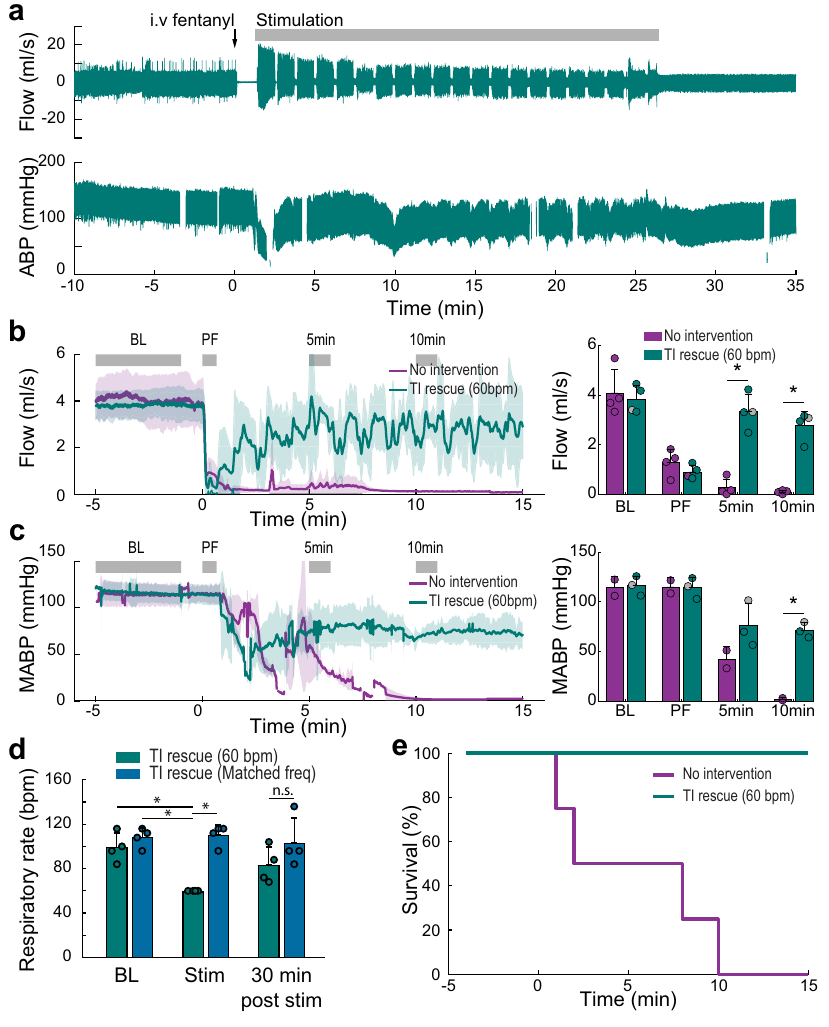
Fig. 2 Intramuscular TI stimulation (TI rescue) prevents fatal apnea by restoring diaphragm activation after opioid overdose. Spontaneously breathing rats under urethane anesthesia received an intravenous injection of fentanyl (30 mcg/kg) suf fi cient to cause lasting respiratory suppression. Following fentanyl dosing, animals received intramuscular TI stimulation or no intervention. Panel a shows an example of sustained restoration of respiratory air fl ow when the stimulation was initiated shortly after opioid overdose-induced apnea, and was delivered with a pattern of 60 s on and 3 s off until spontaneous breathing resumed. Note: The gaps in the blood pressure traces indicate when arterial blood samples were taken. b Average respiratory air fl ow (two-way ANOVA: group F(1) = 40.84, p < 0.0001; time F(3) = 41.86, p < 0.0001; interaction F(3) = 21.4, p < 0.0001) and ( c ) mean arterial blood pressure (MABP) ( n = 4 animals/group, two-way ANOVA: group F(1) = 19.81, p = 0.0008; time F(3) = 45.95, p < 0.0001; interaction F(3) = 7.82 p = 0.0037). The gray bars indicate time periods selected for quantitative comparison (Baseline – BL, immediately Post Fentanyl – PF, fi ve minutes – 5 min, and ten minutes – 10 min after fentanyl). The gray dots indicate data points from the animals used for the example traces in panel a, (mean + 1 standard deviation; asterisk (*) indicates p < 0.05). d TI stimulation restored ventilation and prevented fatal apnea in all animals (TI rescue). TI stimulation with a 1 Hz beat frequency produced a respiratory rate of 60 breaths per minute (bpm) during stimulation. When the beat frequency was targeted to the endogenous respiratory rate, there was no difference in the evoked vs. spontaneous respiratory rate ( n = 4 animals, two-way ANOVA: group F(1) = 22.64, p = 0.0002; time F(3) = 3.85, p = 0.0407; interaction F(3) = 5.03, p = 0.0183). e Survival curve for no-intervention ( n = 4 animals) and TI rescue (60 bpm) conditions ( n = 4